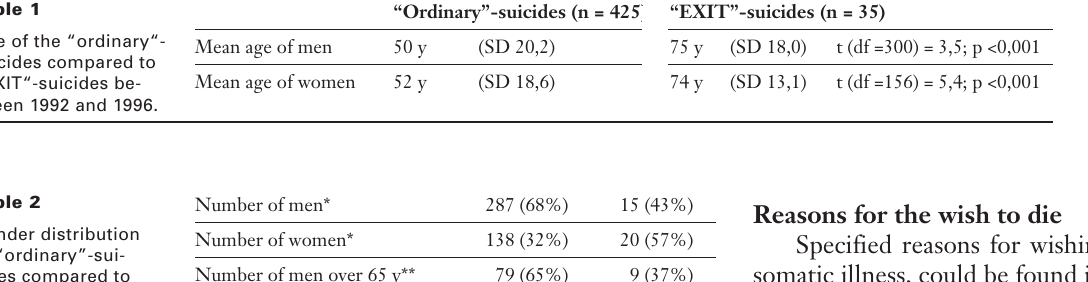
Gender distribution of “ordinary”-sui- cides compared to “EXIT”-suicides be- tween 1992 and